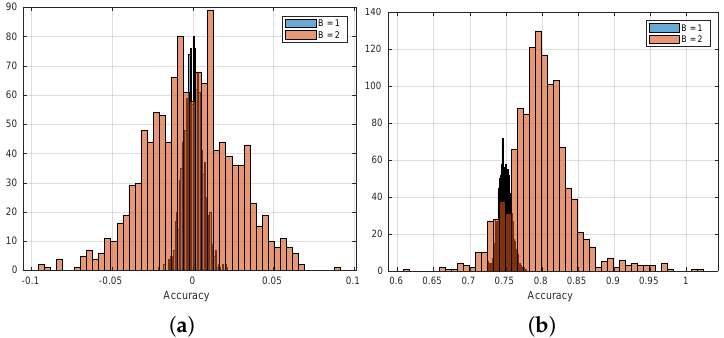
Figure A9. Histograms for the conclusions about the effect of factor B on the expected accuracy performance, represented for the two levels of such factor with additional restrictions on the population. ( a ) Factor C = 1. ( b ) Factor C = 2.